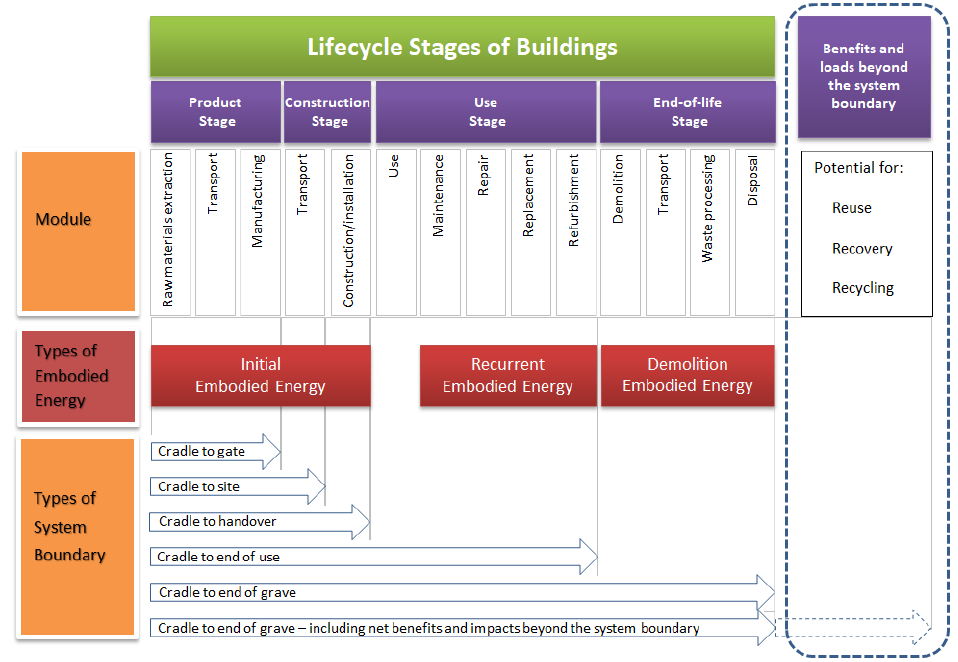
Figure 1. Energy consumption phases of buildings during their lifecycle period, with system boundaries. Adopted from